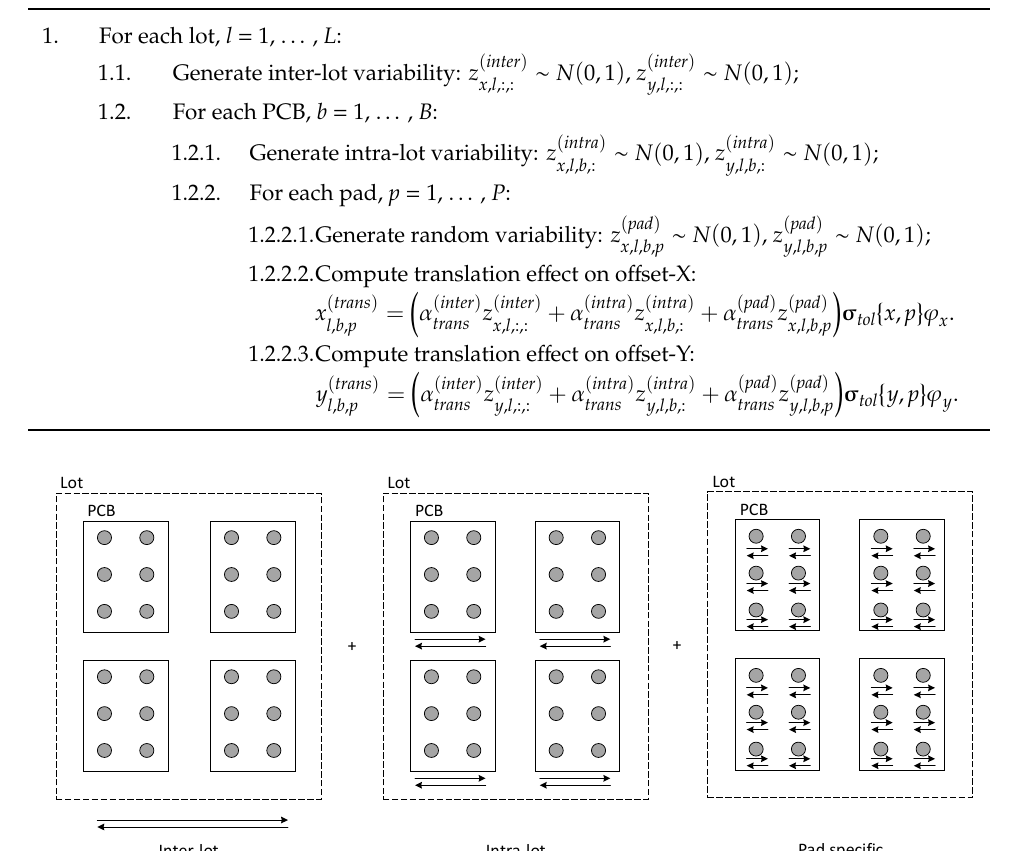
Table 3. Pseudo-code for generating the translation effect on offset-X and offset-Y.